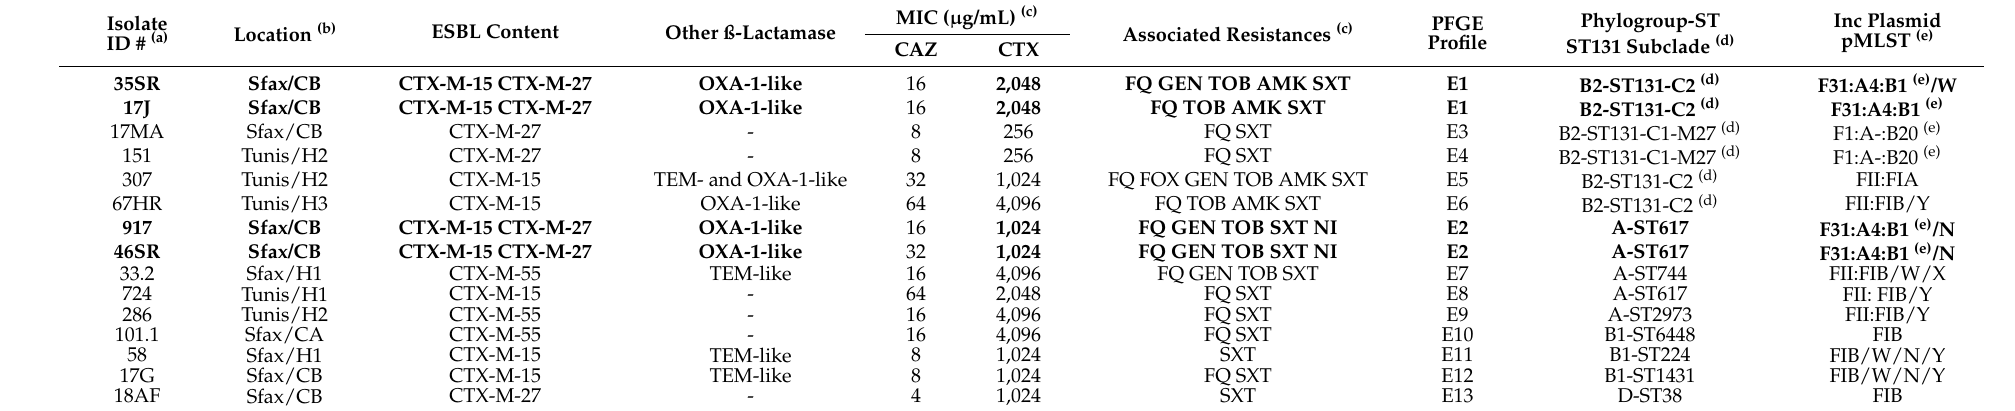
Table 1. Characteristics of the 15 ESBL-producing E. coli